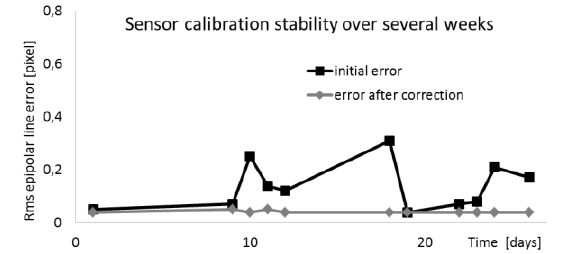
Table 2: Influence of calibration parameter error  E on measurement errors of two spheres